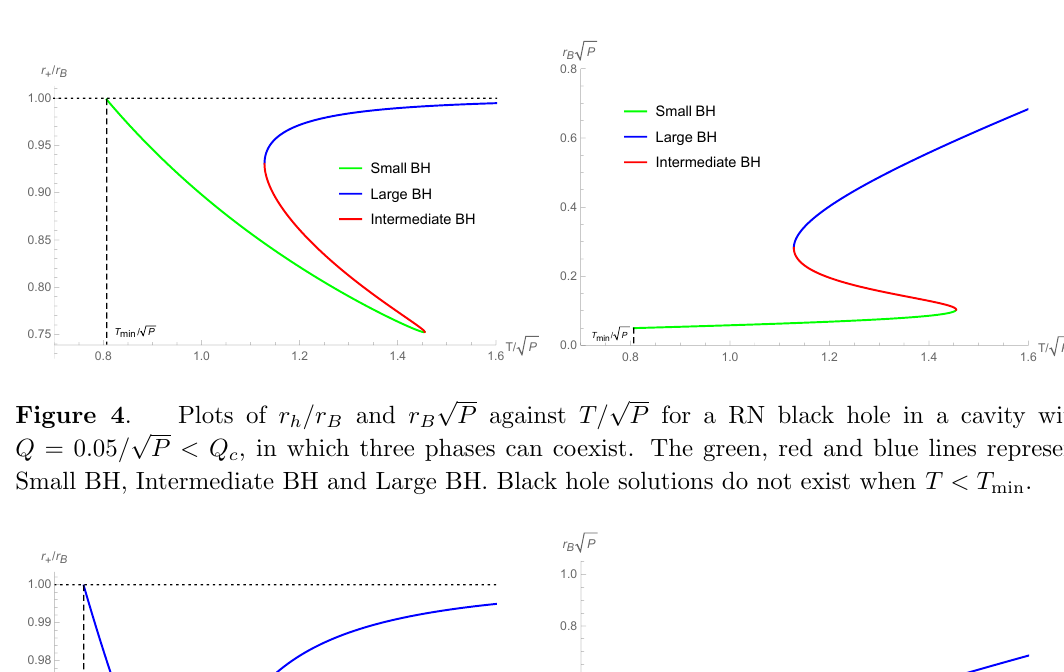
Figure 5 . Plots of r h =r B and r B